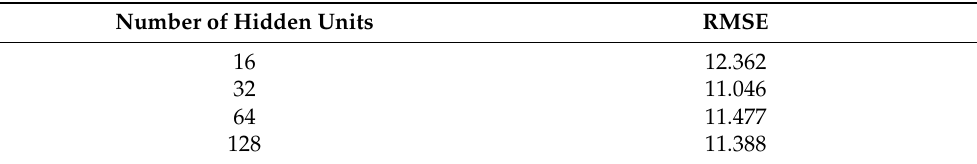
Table 9. Comparison of the number of hidden cells of A-BIGRU